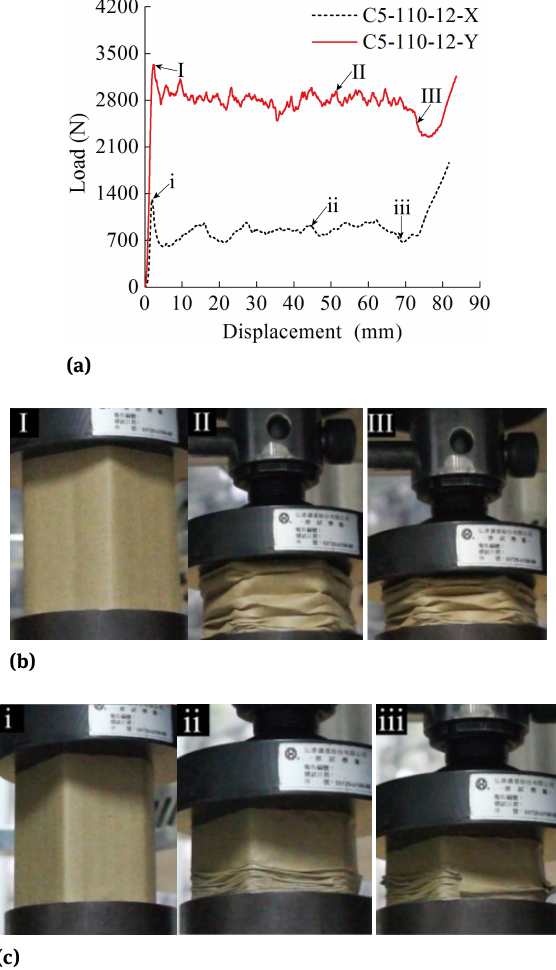
Figure 9: Axial compression of regular pentagon paper corrugation tubes: (a) load and displacement curves; (b) deformation of tube along X direction; (c) deformation of tube along Y